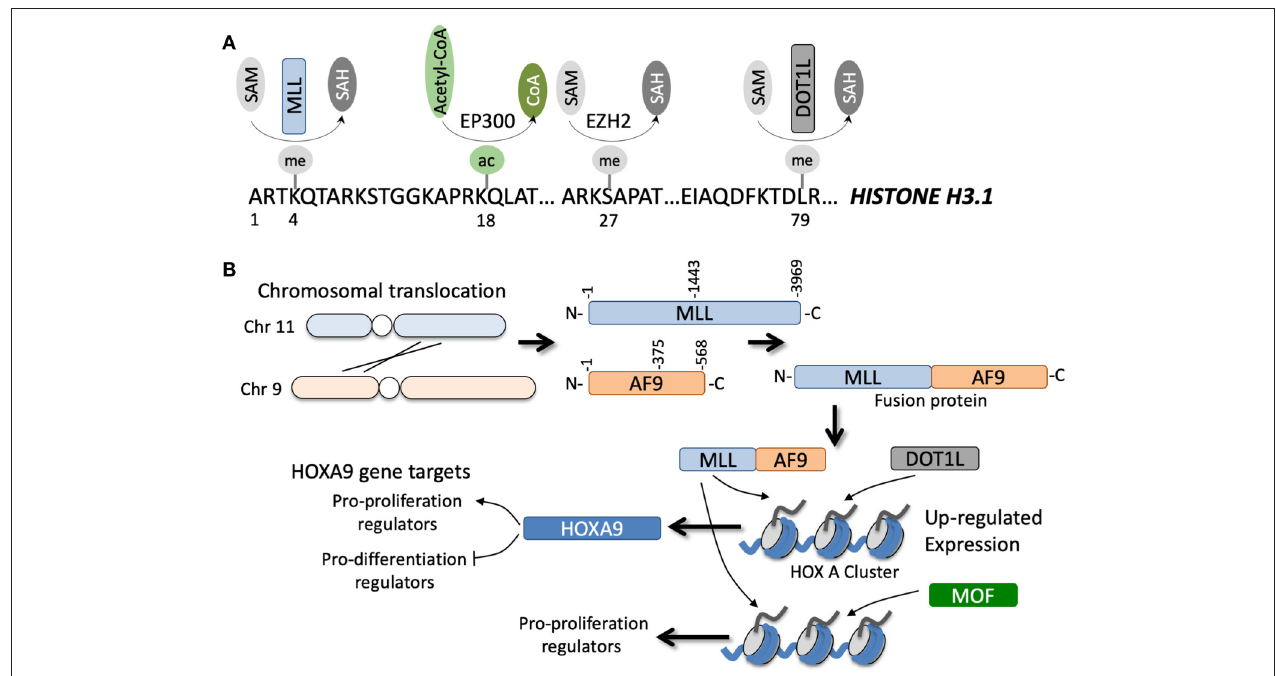
FIGURE 2 | (A) Specific amino acids along the N-terminal region of histone H3.1 can be post-translationally modified by various enzymes in a co-factor dependent manner. (B) Example of a chromosomal translocation event between chromosomes 11 and 9 that leads to gene fusion of MLL and AF9. The fusion occurs at various junctions, but generally leads to transcription and translation of an MLL-AF9 fusion protein (note the reciprocal AF9-MLL protein can also be generated but is not shown). The fusion protein can coordinate with DOT1L methyltransferase or MOF acetyltransferase to epigenetically regulate numerous gene targets, for example genes in the HOXA cluster, that directly and indirectly promote